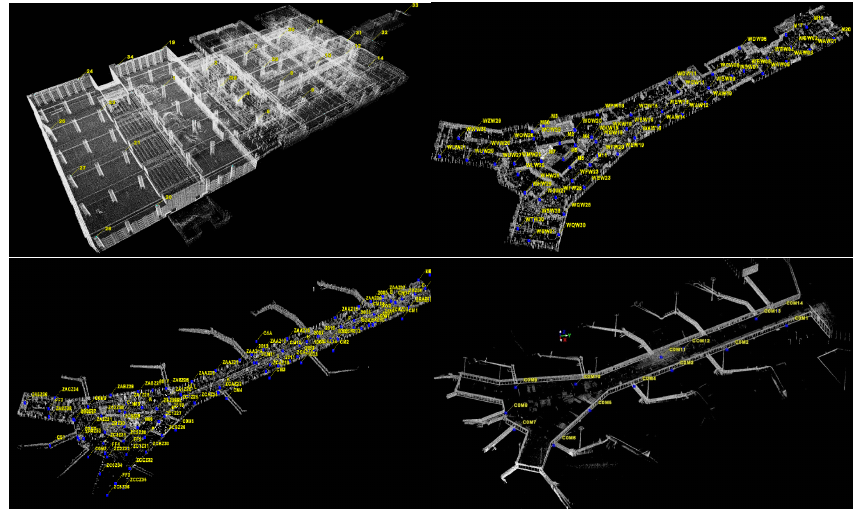
Figure 1: Overview control points: PVPO (Top left), F-pier (Top right), C-pier V1 (Bottom left) and C-pier V0 (Bottom right). The yellow dots indicate the location of the control